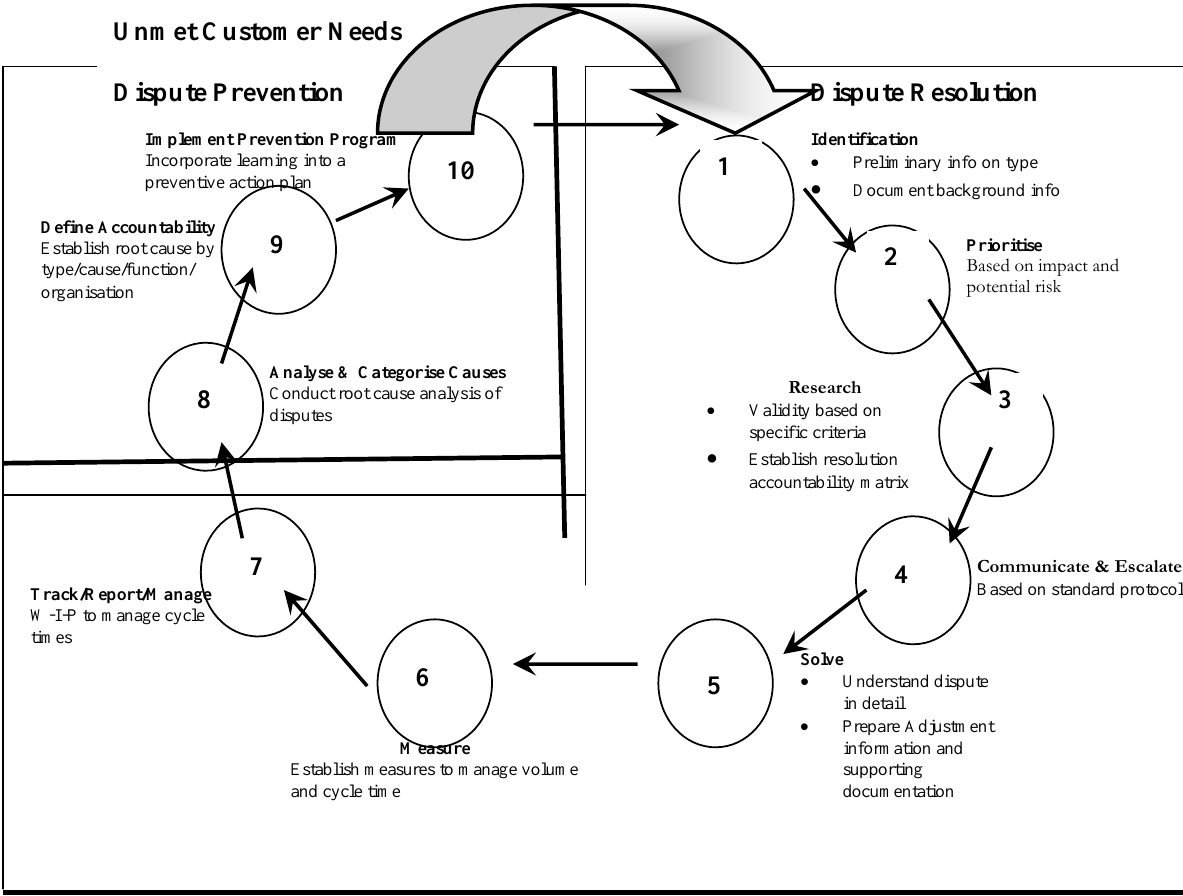
Figure 1: Service level agreement dispute resolution